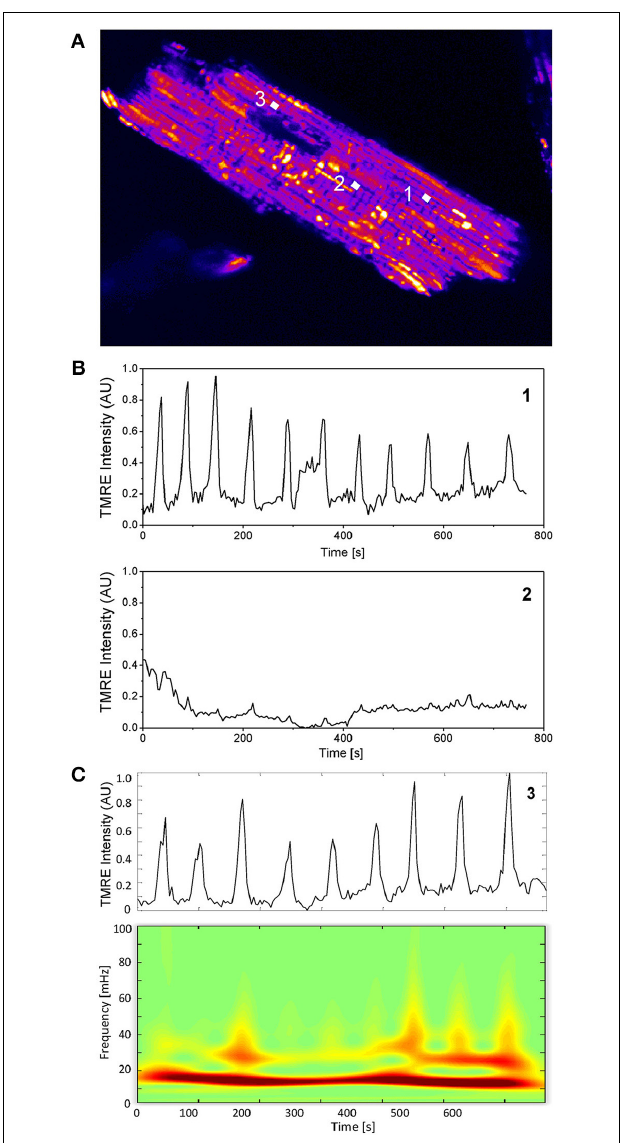
FIGURE 1 | Single mitochondrial signals and wavelet analysis. (A) Mitochondria in cardiac myocytes are densely packed and their individual TMRE signal can be extracted as previously described (Kurz et al., 2010a,b). (B) Two mitochondrial signals with different oscillatory patterns from different locations within the myocyte are shown. (C) Absolute squared wavelet transform over frequency and time of an oscillating mitochondrion. The major frequency component varies between 15 and